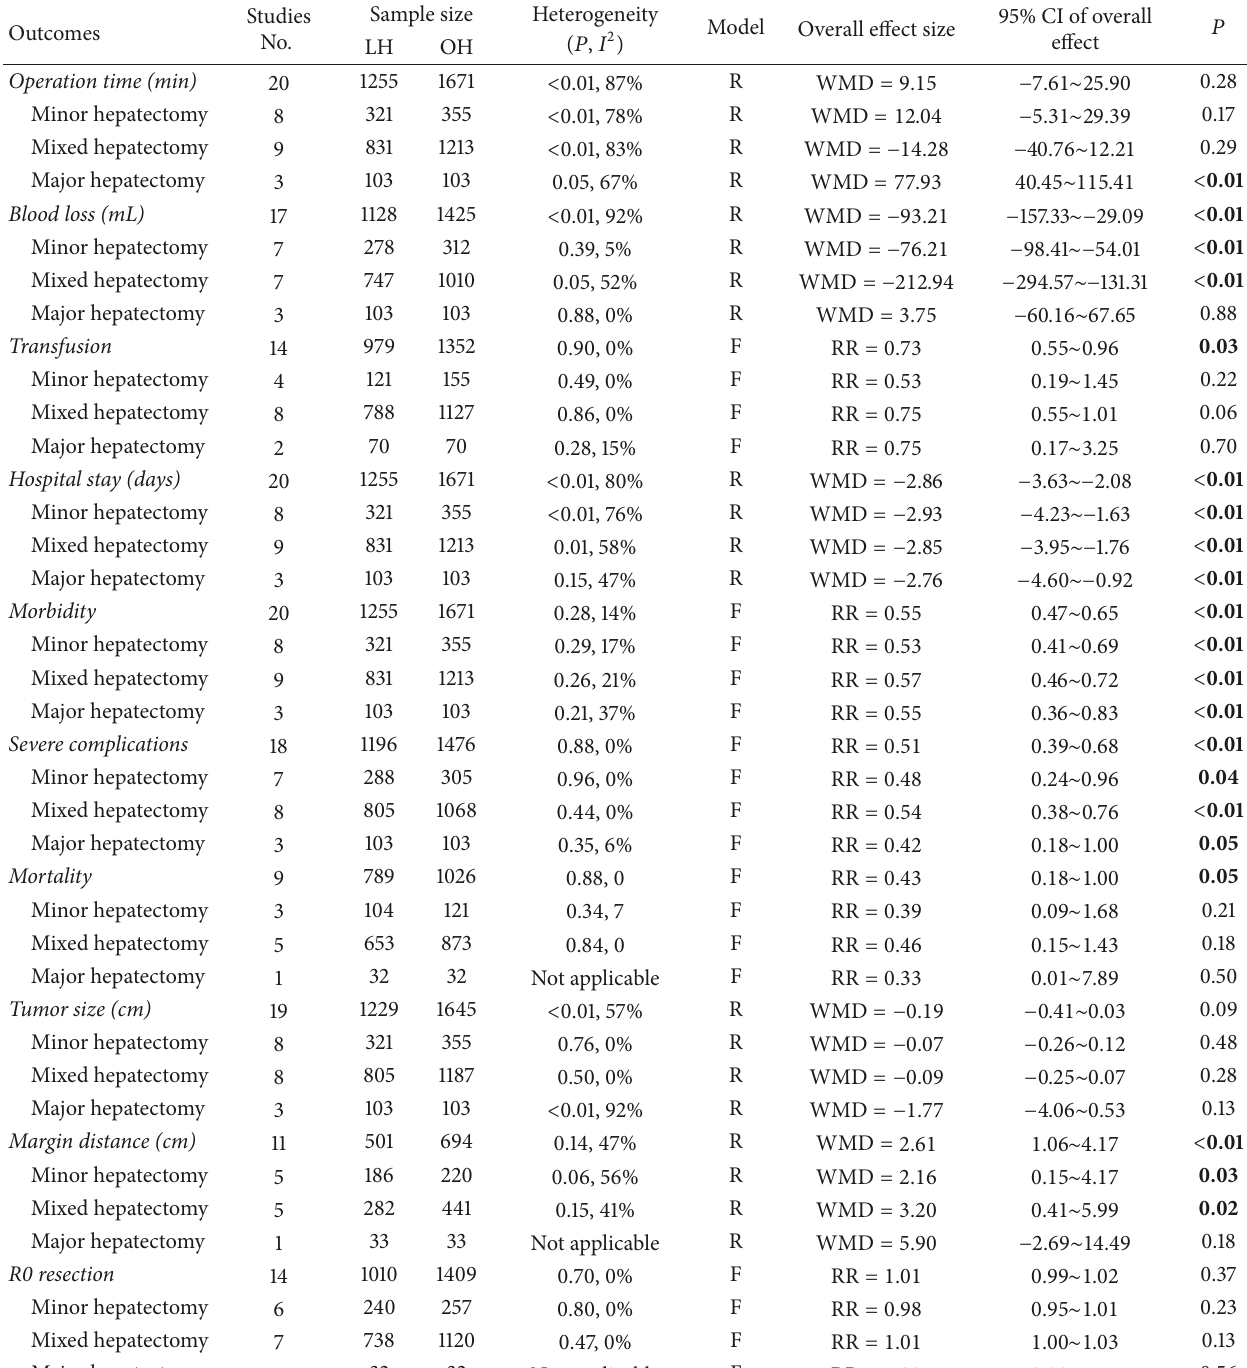
Table 3: Overall outcomes of the